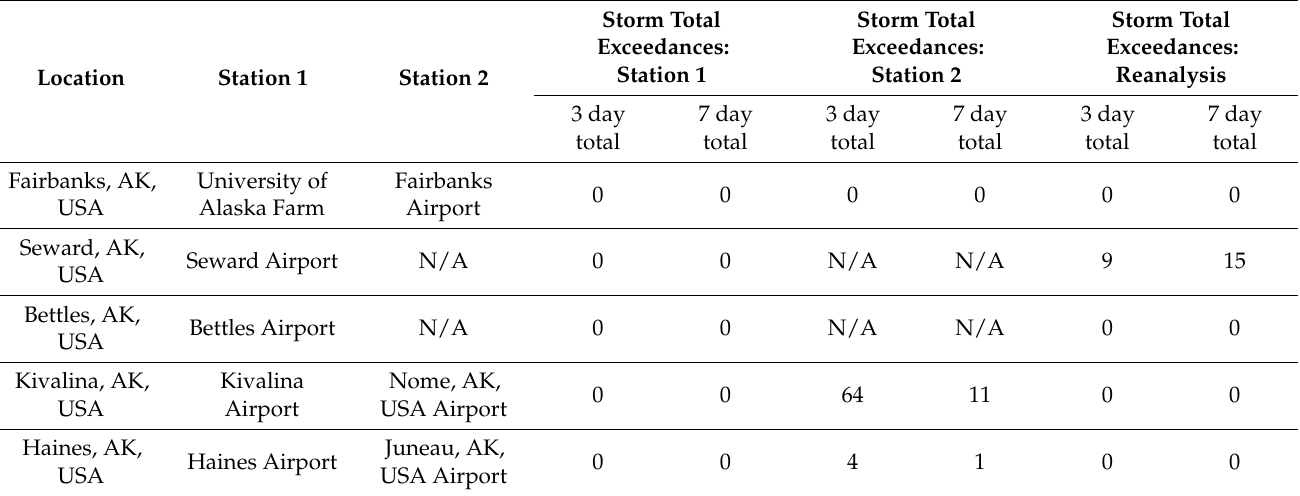
Table 2. Historical storm total exceedances for 3 and 7 day durations, calculated from station and ERA5 data. Station 1 typically refers to the closest station, whereas Station 2 refers to a nearby station with a more complete record when Station 1 has poor coverage. The two Fairbanks stations have nearly complete records: UAF Farm (Station 1) and Fairbanks Airport (Station